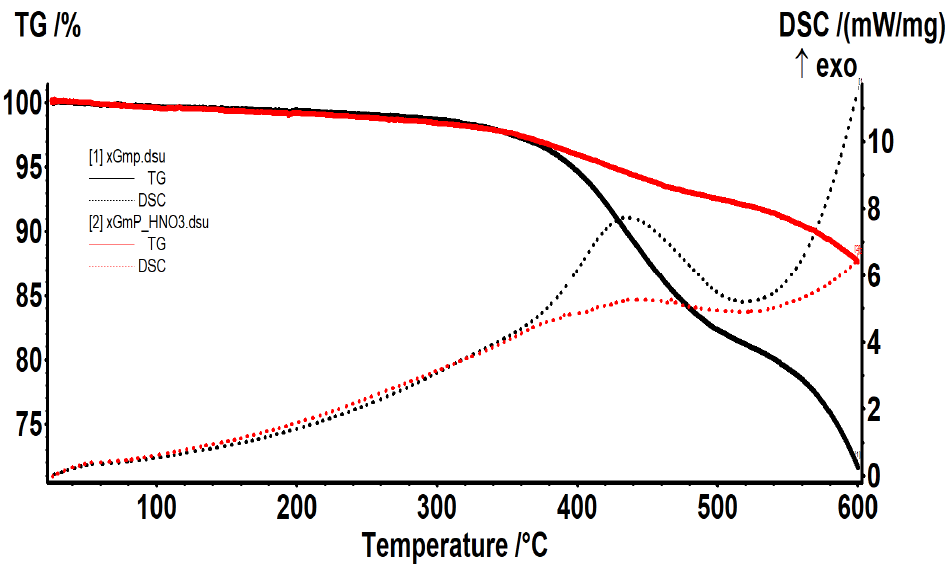
Figure 5. Thermograms of xGnP (black line) and ox-xGnP(red line).